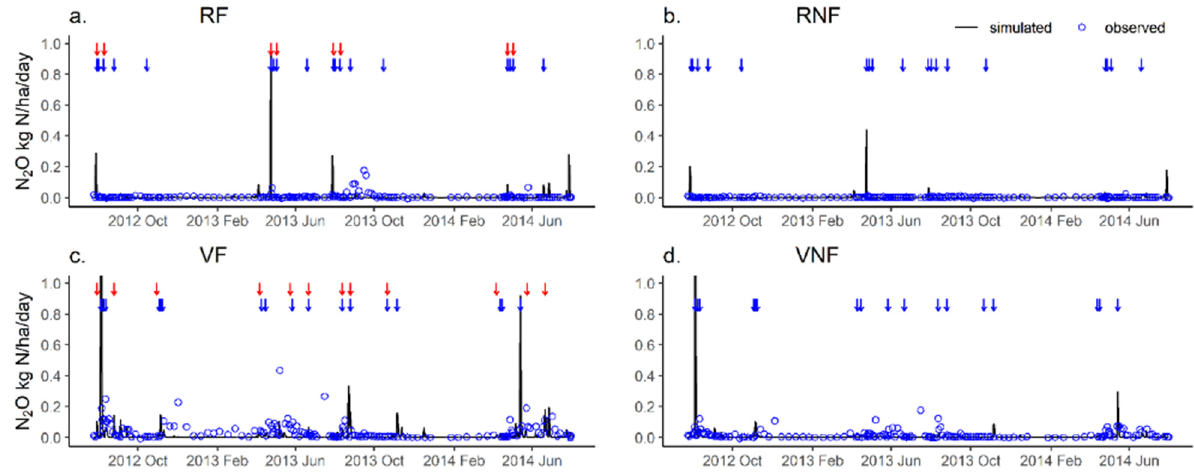
Figure 4. Observed and simulated ( a – d ) daily N 2 O emission under the different cropping systems and fertilizations from 2012 to 2014. RF: rice with fertilization; RNF: rice without fertilization; VF: vegetable with fertilization and VNF: vegetable without fertilization; red arrows indicated fertilizer application events; and blue arrows indicated irrigation events.